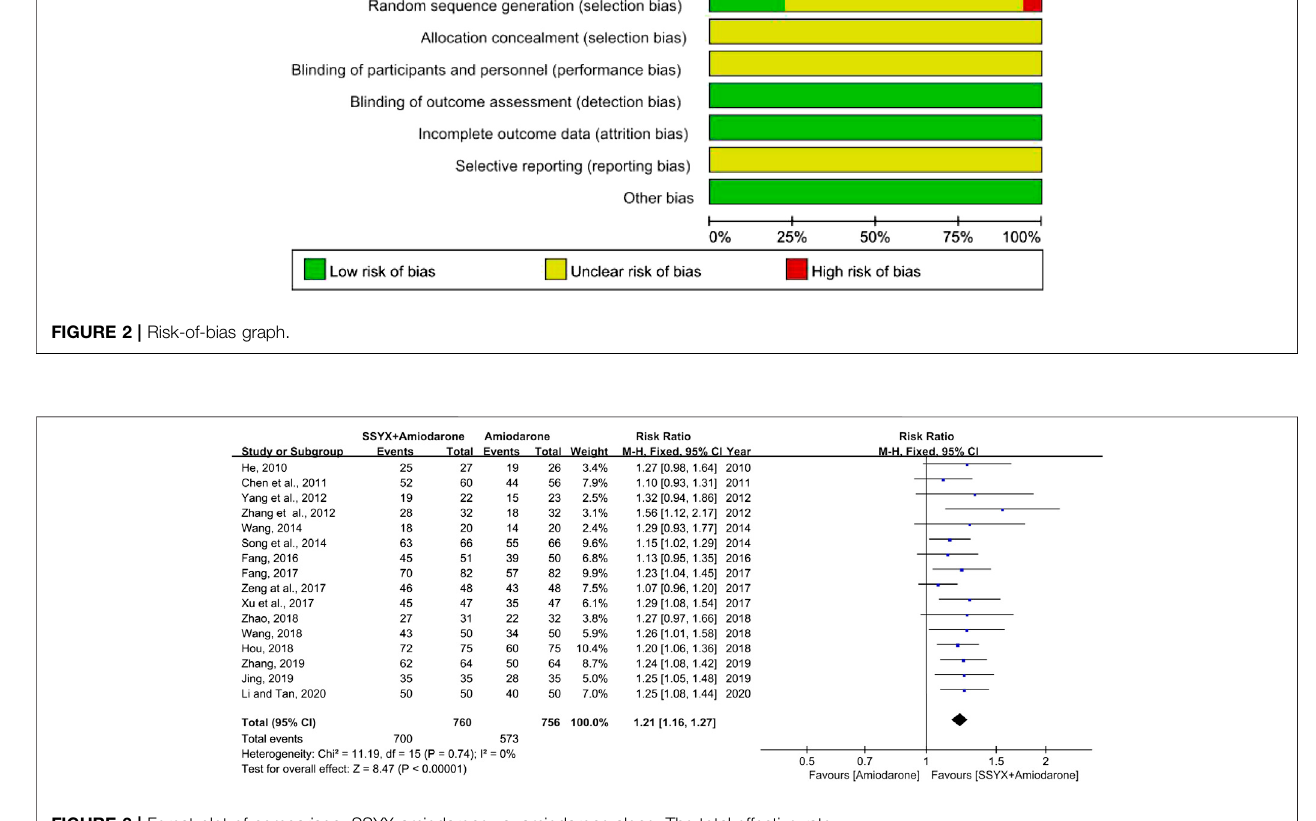
FIGURE 3 | Forest plot of comparison: SSYX-amiodarone vs. amiodarone alone: The total effective rate.